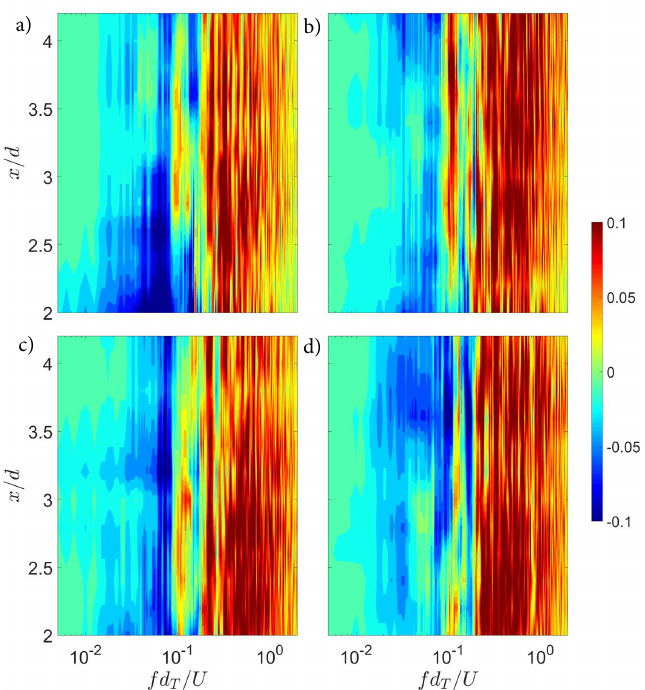
Figure 13. Compensated velocity spectra difference ∆ ( f φ ) normalized by its local maximum between the wake and incoming flow for α = ( a ) 0 ○ , ( b ) 30 ○ , ( c ) 60 ○ , and ( d ) 90 ○ .